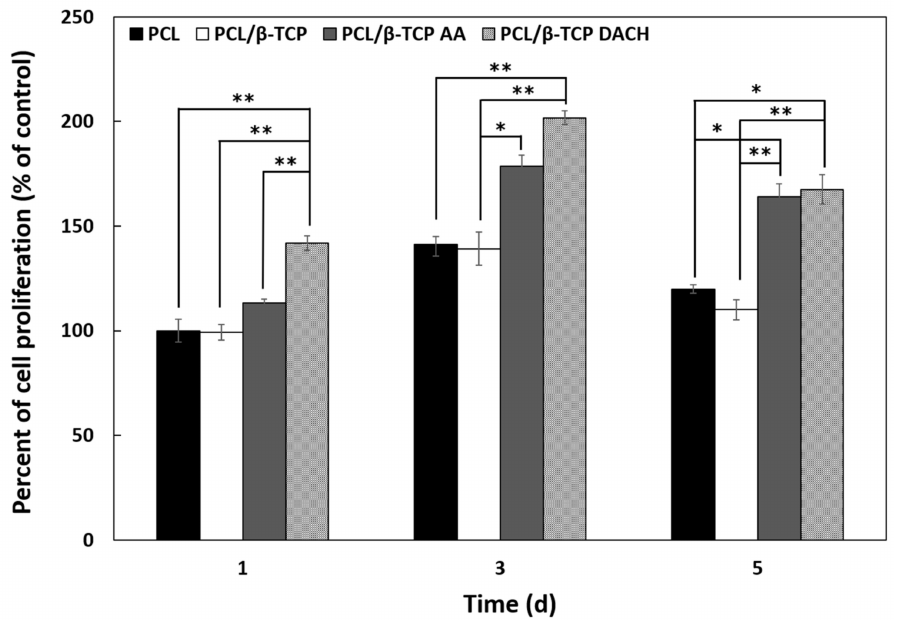
Figure 8. Evaluation of cell proliferation on 3D scaffolds: Cell growing within PCL, PCL/ β -TCP, PCL/ β -TCP AA, and PCL/ β -TCP DACH scaffolds for 1, 3, and 5 days, as determined by the MTT assay. Cell proliferation was found significantly higher in DACH plasma treated 3D PCL/ β -TCP scaffolds as compared to the pristine PCL scaffold on one day ( n = 3, ** p < 0.01 and * p < 0.05 compared to values shown by PCL scaffolds on one day). Statistical analysis was carried out using One-way ANOVA followed by post hoc Tukey test.